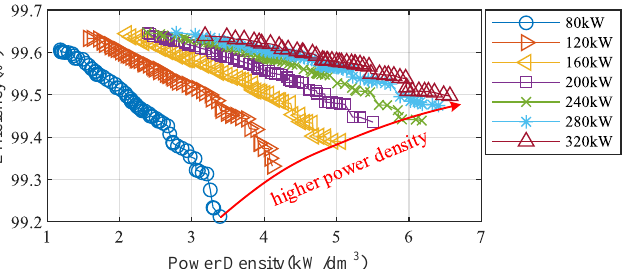
Figure 23. Comparison of Pareto fronts of CW ELII MFT designs under different power requirements (different current amplitudes; same leakage inductance in per unit, 50%).